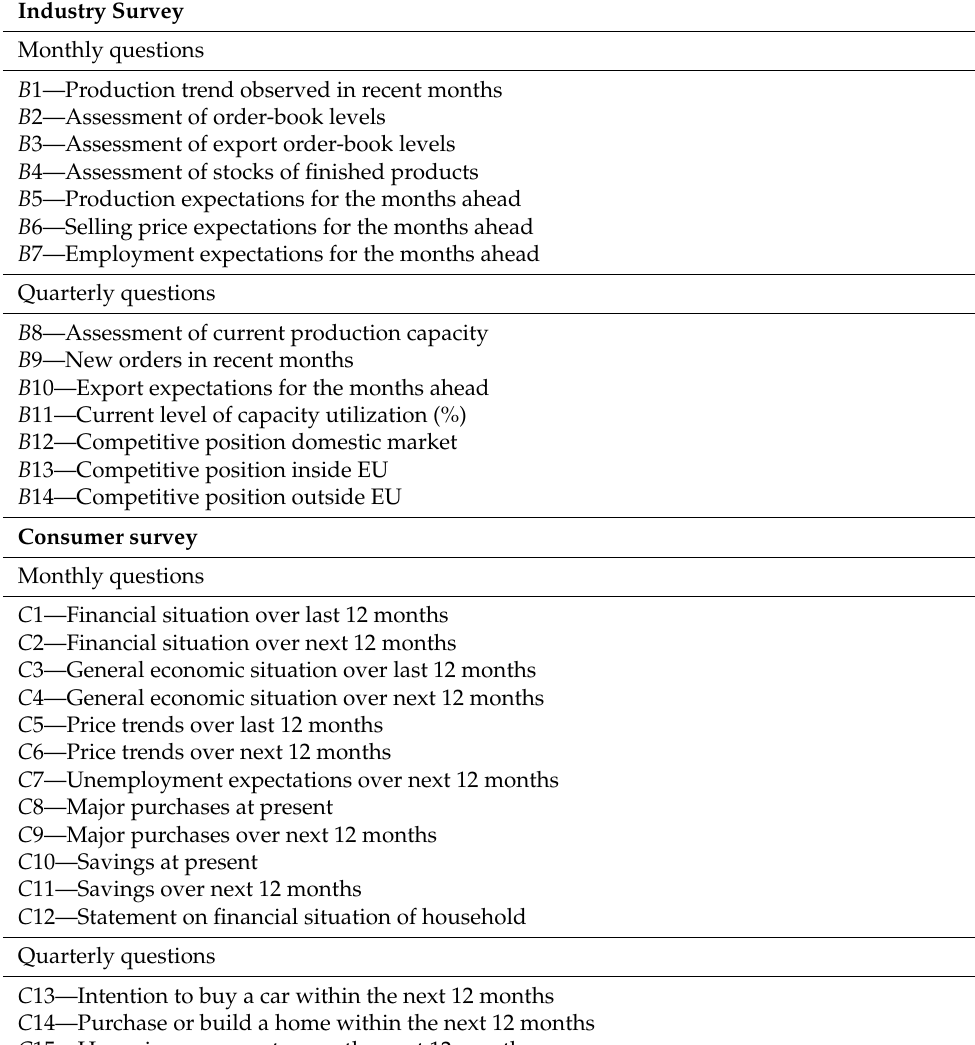
Table A1. Survey indicators.